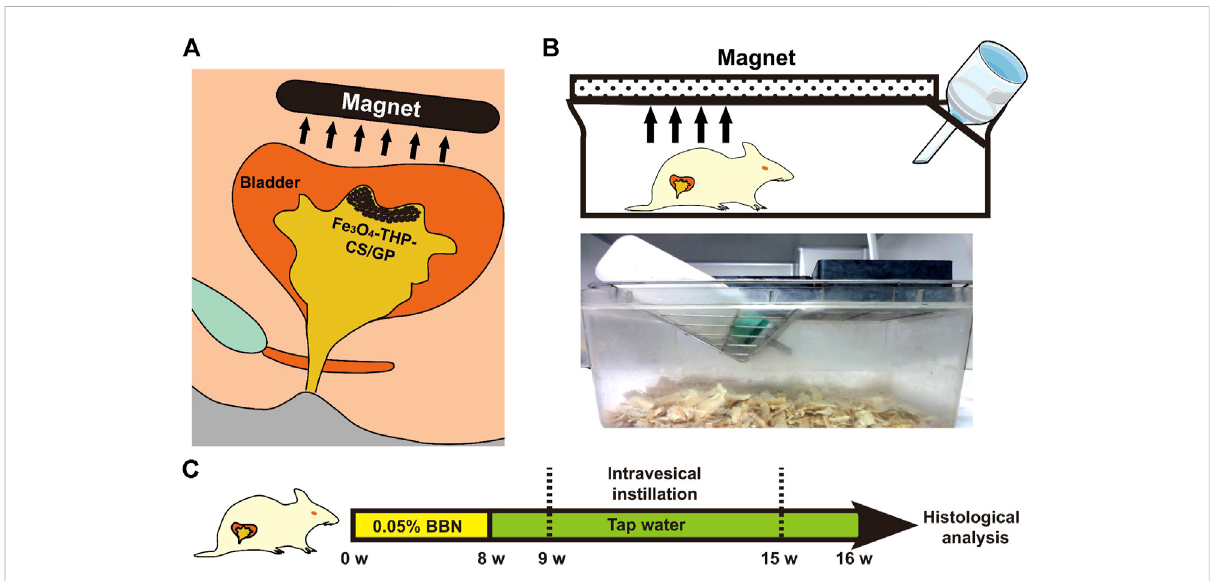
FIGURE 8 Schematic diagram of the in vivo antitumor activity of Fe 3 O 4 -THP-CS/GP. (A) Schematic diagram of the clinical application of Fe 3 O 4 -THP-CS/ GP. (B) Schematicillustrationoftheratterrarium.AmagnetabovetheterrariumattractsFe